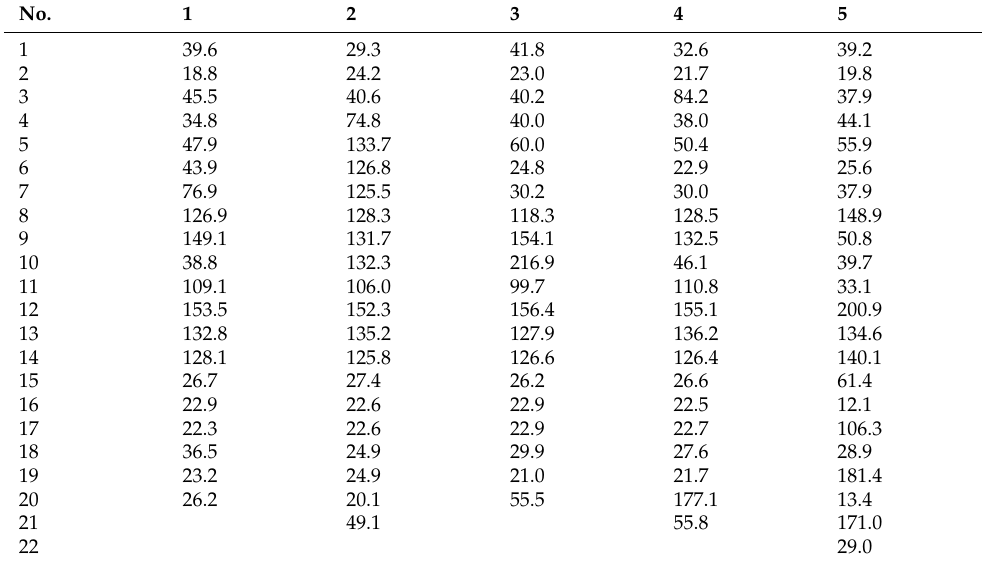
Table 1. 13 C-NMR data for Compounds 1 – 5 ( δ in ppm, 150 MHz for 13 C NMR in CDCl 3 ).